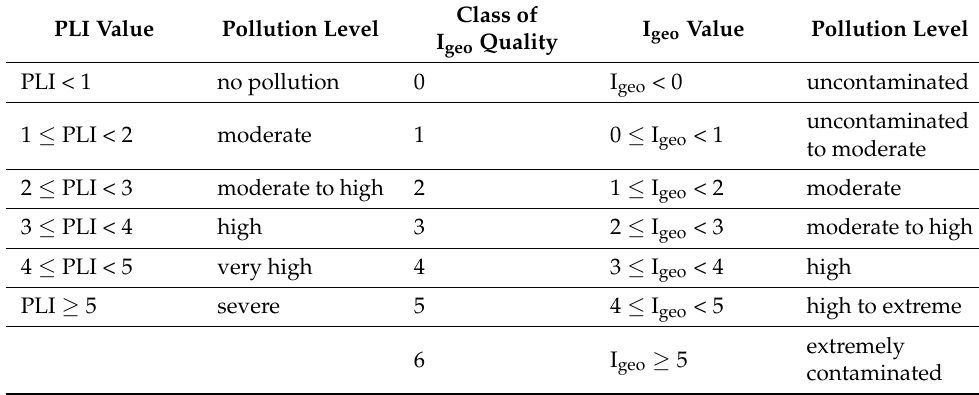
Table 2. The classification of the pollution level of PLI and I geo indices according to Zhang et al.